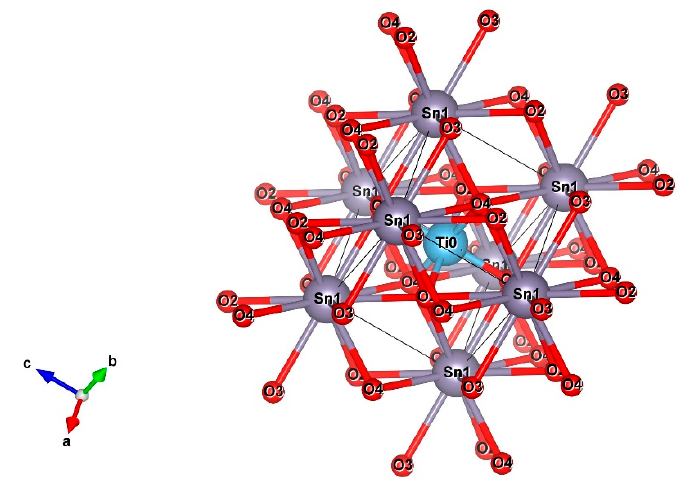
Figure 1. Crystal structure of cubic SnTiO 3 .